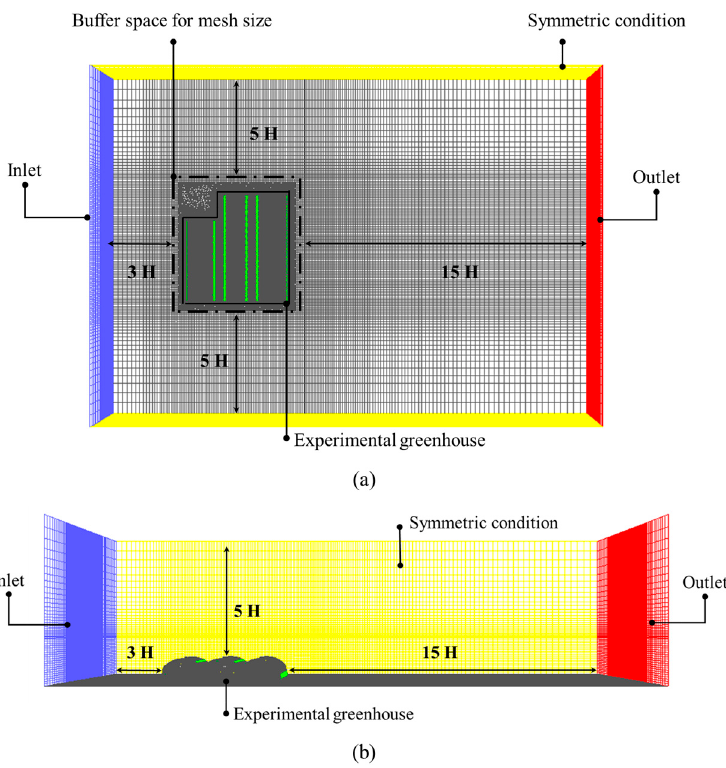
Figure 6. Designed CFD model for greenhouse and computational domain: ( a ) top view and ( b ) side view for CFD computation domain.